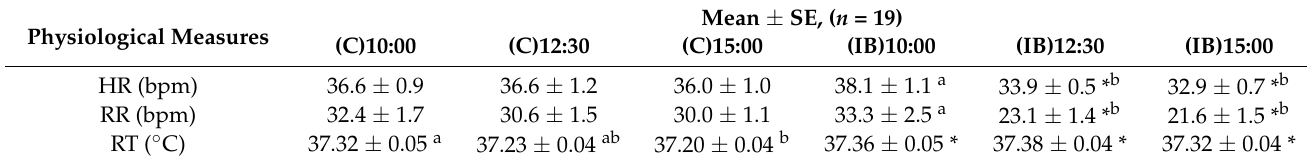
Table 6. Mean ± SE of heart rate (HR), respiratory rate (RR), and rectal temperature (RT). Physiological Measures